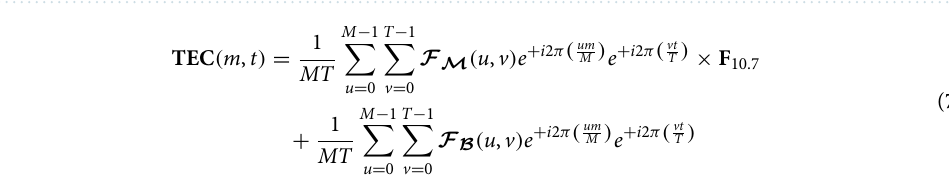
Figure 11. Diagrams of daily mean TECU in ascending and descending phases (top-left and right) and Monthly mean TECU normalized at F10.7 = 100 SFU during ascending and the descending phases (bottom-left and